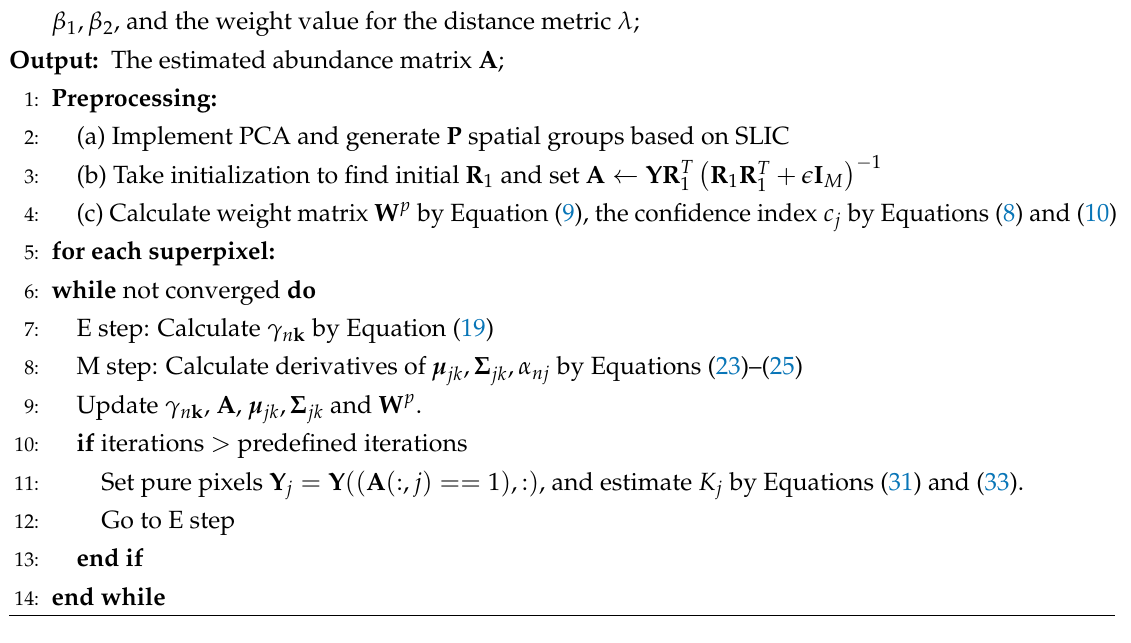
Algorithm 1 Details for unsupervised of